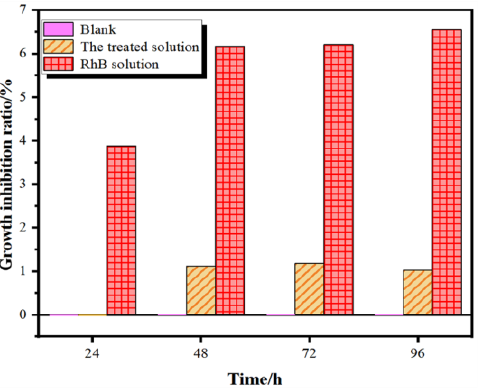
Figure 5. Time-dependent growth inhibition rates of C. vulgaris in different solutions.